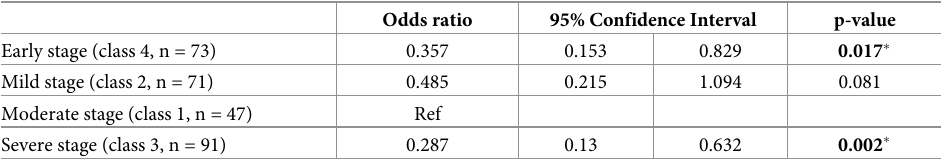
Table 4. Logistic regression results of stage of PWD on potential depression among